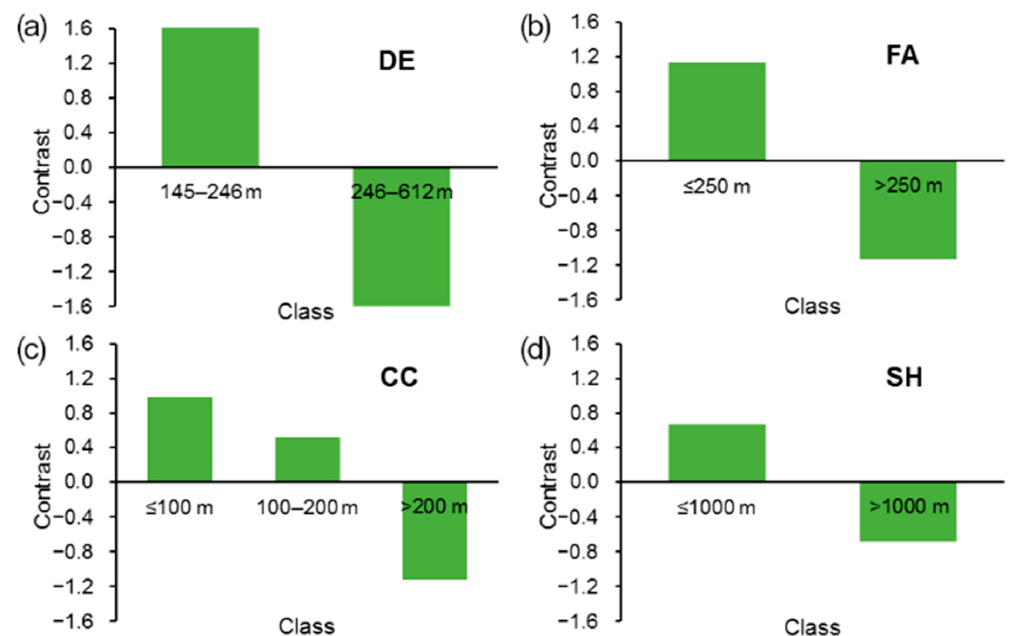
Figure 5. Contrasts of the statistically significant classes of each evidential theme used to generate the map in Figure 6. ( a ) DE: elevation, ( b ) FA: distance to faults, ( c ) CC: distance to the carbonate–non-carbonate rock contact and ( d ) SH: distance to sinkholes and sinking streams.